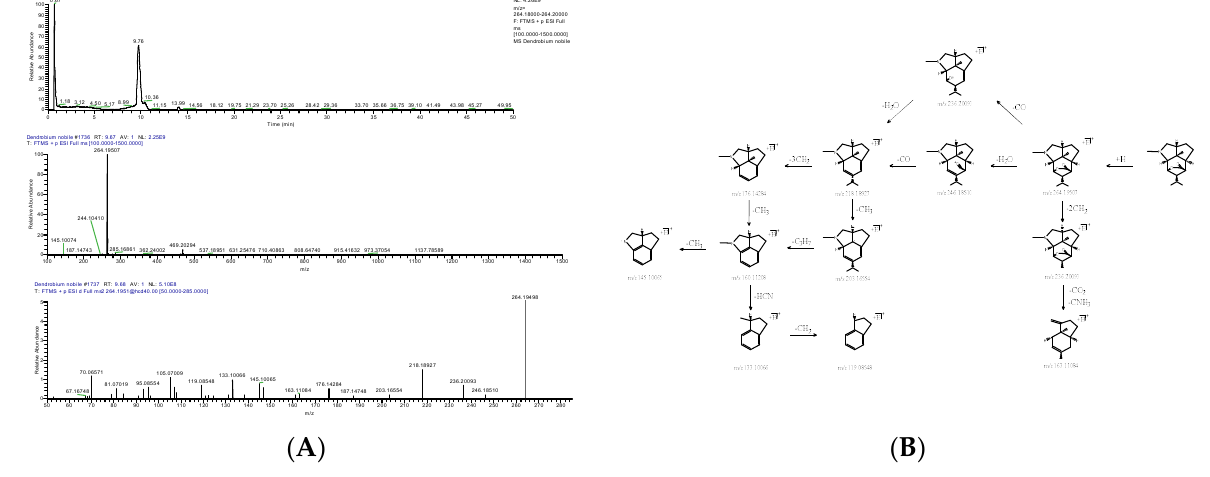
Figure 2. Extracted ion chromatogram: MS 1 and MS 2 spectra in positive ion mode ( A ), and proposed main fragments of dendrobine (DN 10) ( B ).